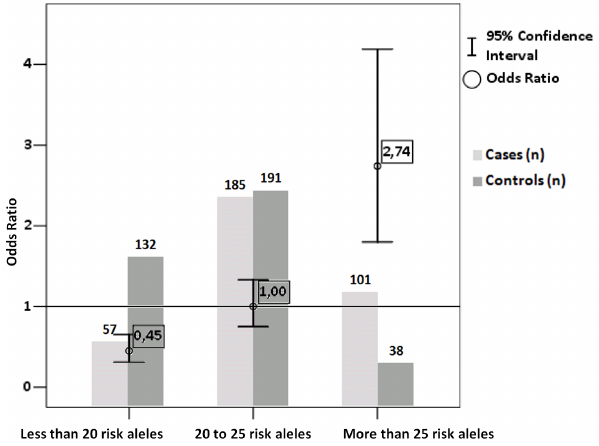
Figure 3. Joint effects of risk alleles on the presence of low HDL-C level. Odds ratios with corresponding 95% confidence interval are shown. Subjects with 20 to 25 risk alleles were used as reference group. Light grey columns indicate number of individuals with low HDL-C levels; dark grey columns indicate number of individuals with high HDL-C